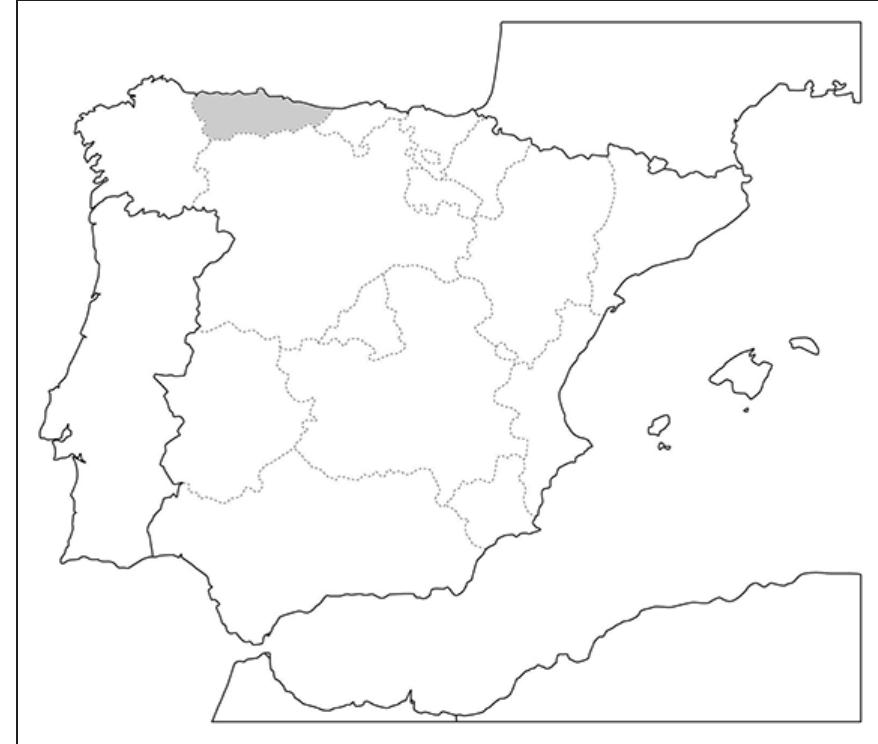
Figure 2: Map showing the location of Asturias (in grey) in